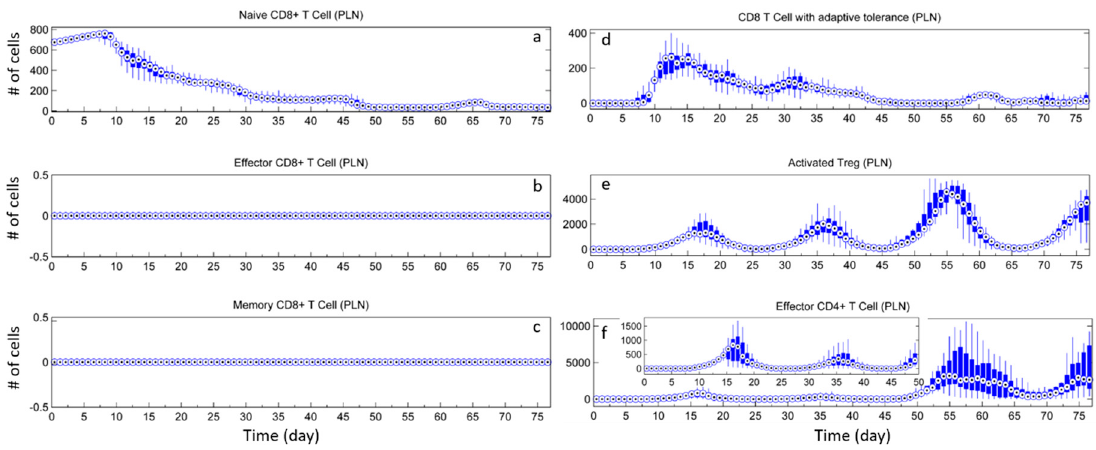
Figure A2. Simulation results for case with initial Tregs (case III). There are initial Tregs but no conversion ability of CD4 + T cells. The number of ( a ) naive CD8 + T cells, ( b ) effector CD8 + T cells, ( c ) memory CD8 + T cells, ( d ) CD8 + T cells with adaptive tolerance, ( e ) activated Tregs, ( f ) effector CD4 + T cells in PLN are shown. Inserts (number of cells vs. time) show small change of cell number in the bottom figures. t = 0 days correspond to 3-week age of mouse.